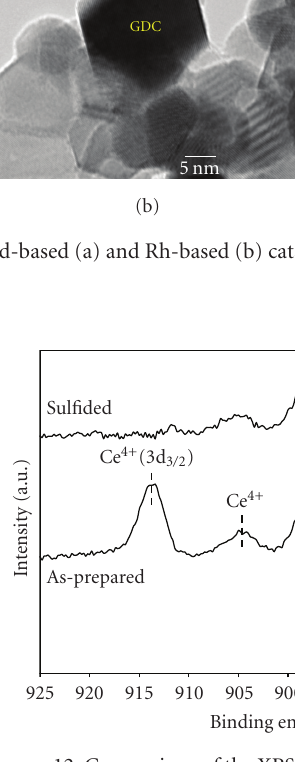
Figure 12: Comparison of the XPS signature of virgin GDC sample with that sulfided at 800 ◦ C for 16h in a gas stream containing 300 ppm H 2